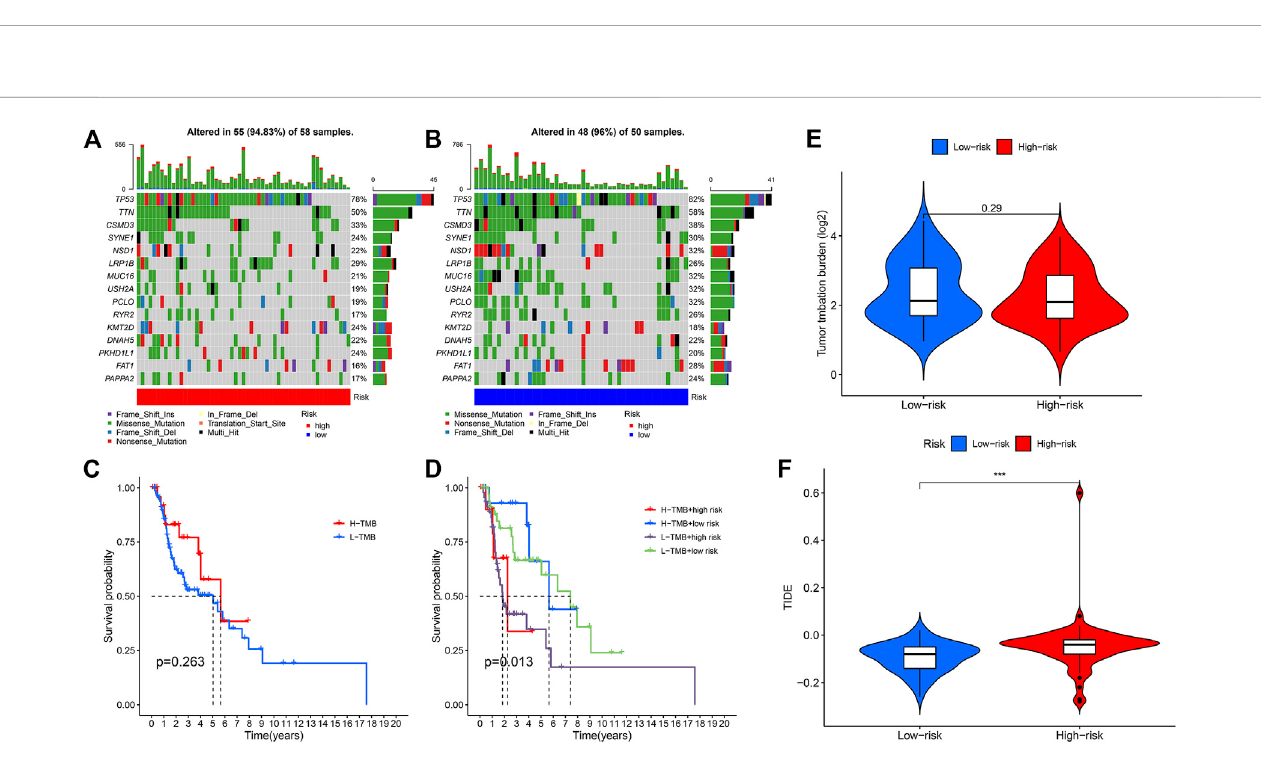
FIGURE 9 (A) Mutation rates and types of top 15 genes in the high-risk group. (B) Mutation rates and types of top 15 genes in the low-risk group. (C) Kaplan-Meier curve to show survival of patients in different TMB groups. (D) Kaplan-Meier curve to show survival of patients in different TMB and risk groups. (E) TMB between high and low risk groups. (F) TIDE value between high and low risk groups (*** p <